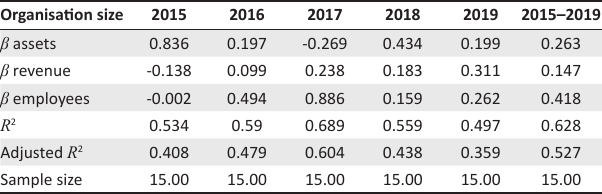
TABLE 4: Multiple regression – Organisation performance on chief executive officers’ fixed remuneration. Organisation